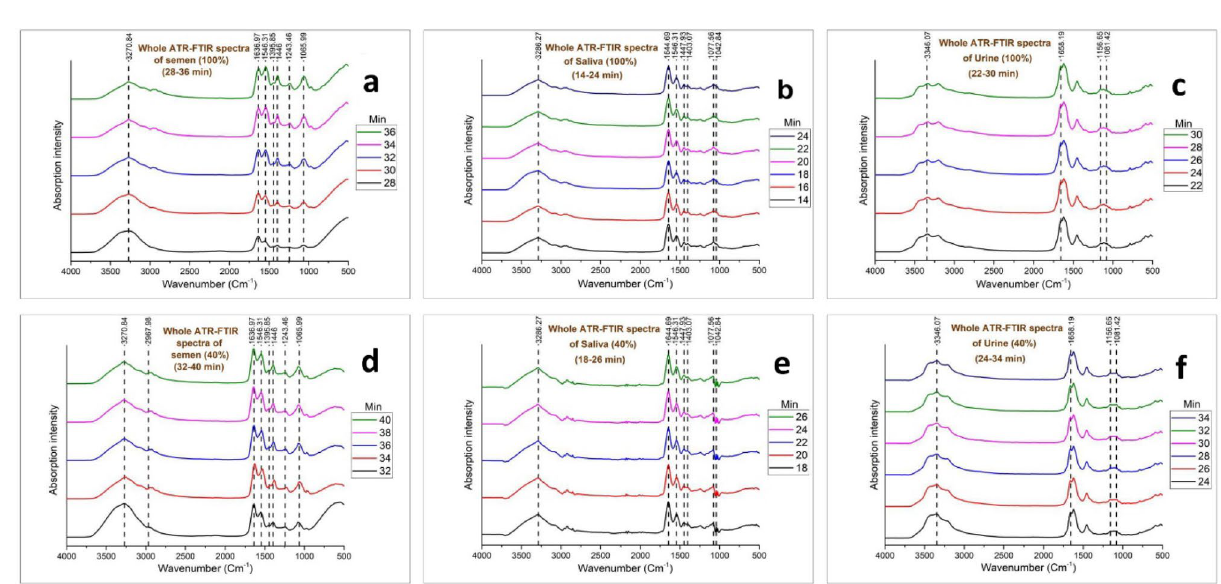
Figure 2. Whole ATR FTIR Phase II spectra for ( a ) 100% semen, ( b ) 100% saliva, ( c ) 100% urine, ( d ) 40% semen, ( e ) 40% saliva, ( f ) 40%